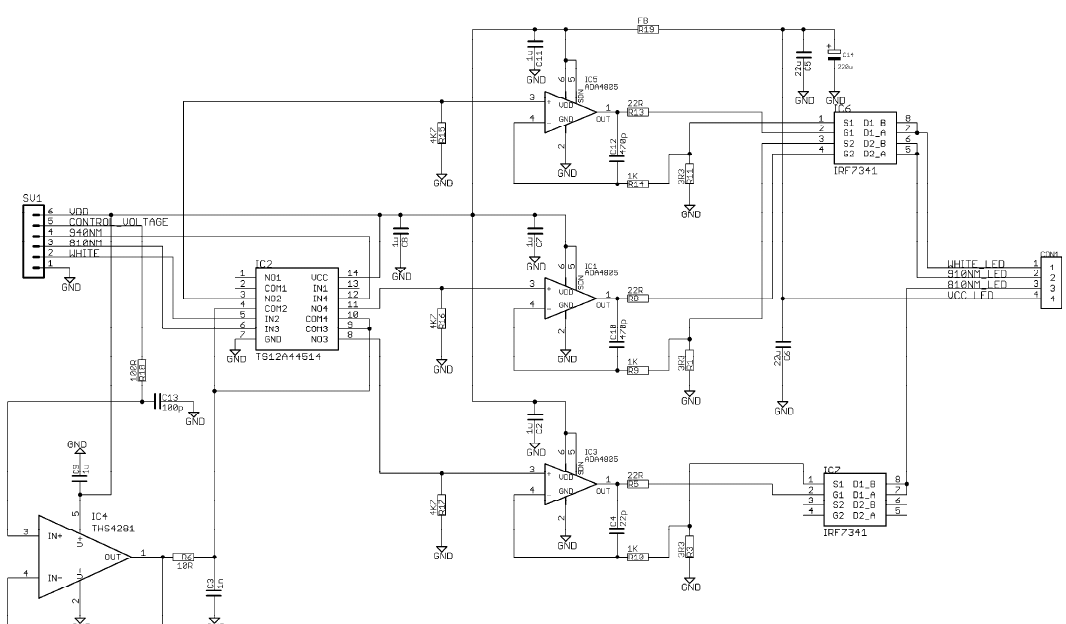
Figure A5. Three-channel LED driver. The led driver is based on IC1, IC3, IC5, IC6, and IC7. The voltage in the input of each ADA4805 controls the current of each LED array. This circuit is controlled by the CPU that is connected to SV1. The control voltage of the drivers is different for each spectral band to account for the different sensitivity of the photodiode responding to different spectral bands and is produced by the DAC of the main processor. Therefore, with the help of the analogue switch IC2 and the timing signals for the 940nm, 810nm, and white LEDs, the different voltages, in turn, give input to the ADA4805.